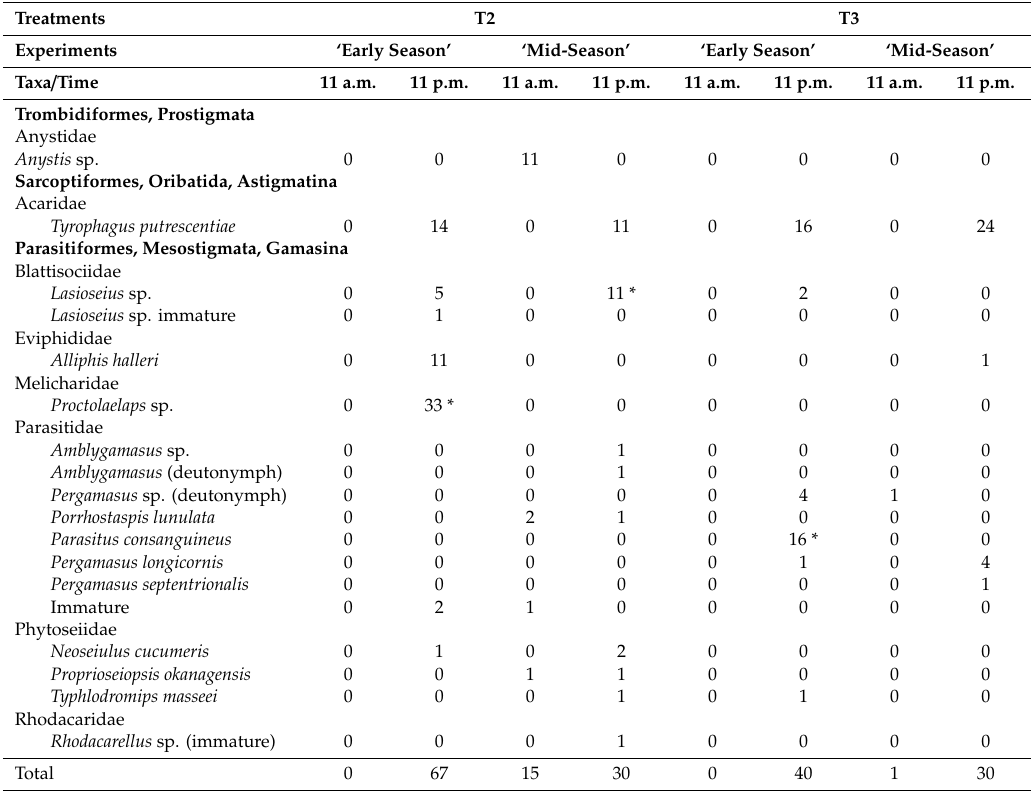
Table 4. Total number of mites (except Tetranychus urticae ) of di ff erent groups extracted with 70% alcohol from whole strawberry plants. ‘Early season’ experiment (oat straw: T2, since 2018; T3, since 2017); ‘Mid-season’ experiment (barley straw: T2, since 2018; T3, lower half layer since 2017 and top half layer since 2018).